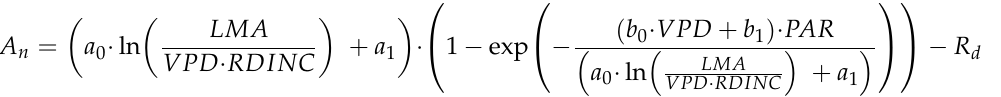
Figure 1. Relationships between the fitted parameters (The maximum net photosynthetic rate, A max , μ mol m − 2 s − 1 ; the apparent quantum yield, AQY; and the dark respiration rate, R d , μ mol m − 2 s − 1 ) for the modified Mitscherlich equation and the relative depth into the crown (RDINC), leaf temperature ( T leaf , °C), vaper pressure deficit (VPD, kPa) and leaf mass per area (LMA, g m − 2 ) in the 752 needle clusters from the five sample trees (open circles). Color circles containing values show Spearman’s correlation coefficients ( α = 0.05).